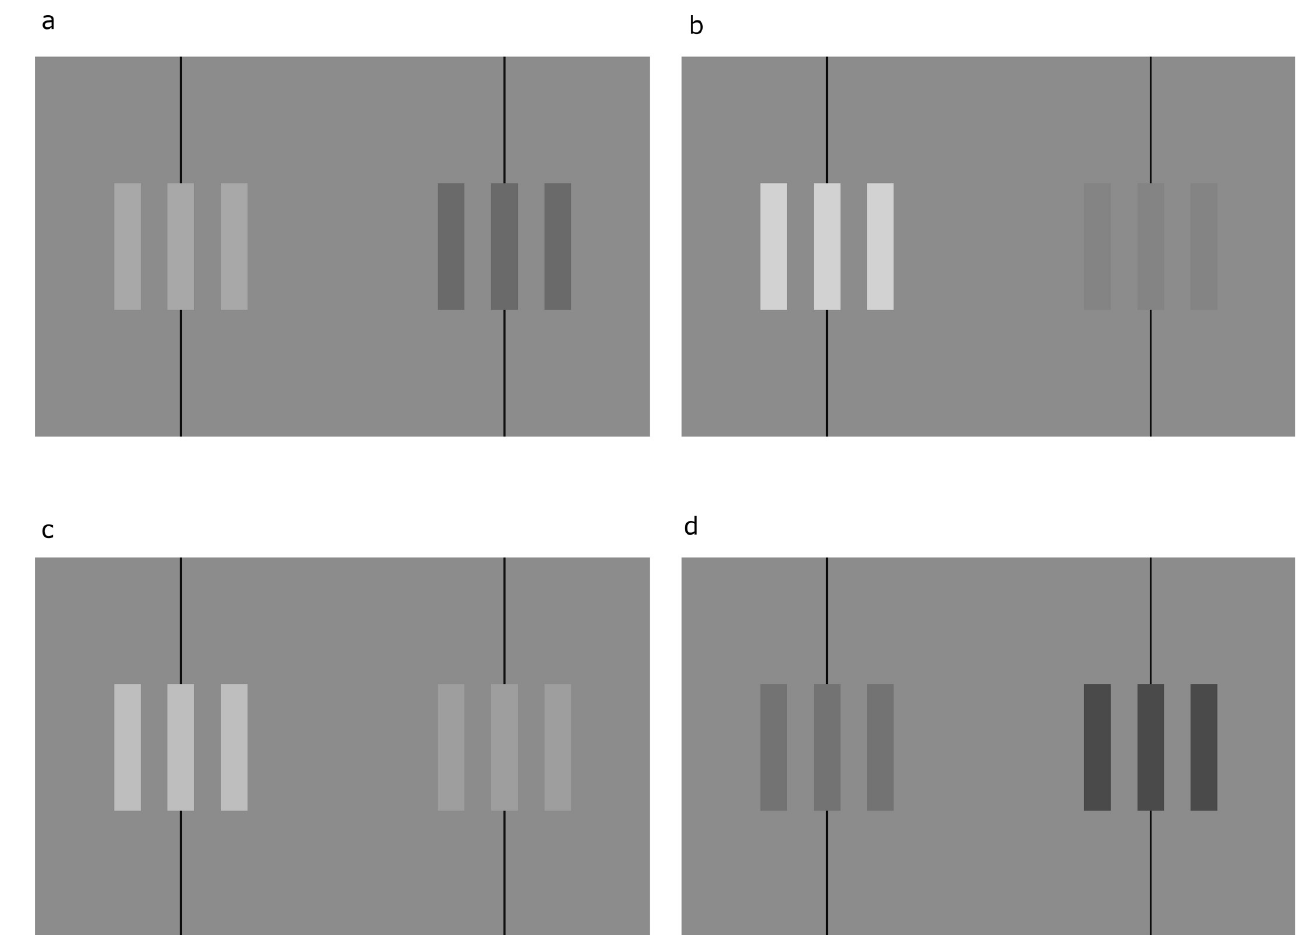
Fig 5. Sample Experiment II stimuli. (a) The "average luminance" condition, with luminance values derived from a grating with dichoptic luminance modulation of 0.4. (b) "Light luminance bars," from dichoptic luminance modulation of 0.4. (c) "Light contrast bars," from dichoptic contrast modulation of 0.5. (d) "Dark bars," from dichoptic luminance modulation of 0.4. The bars straddle the background in (a) and (b), and not in (c) and (d). at the bottom of each plot are the dichoptic luminance or contrast modulation values in the original grating images of Experiment I, allowing direct comparison of these plots to those in Fig 4. That is, the "average luminance" (avg) and "light luminance bars" (llm) plots can be com- pared to the plots for images with dichoptic luminance modulation, the "light contrast bars" (lcn) plots can be compared to the plots for images with dichoptic contrast modulation, and the "dark bars" (dar) plots can be compared to both luminance and contrast modulations. Again, the vertical dotted lines indicate the disparity at which one of the dichoptic gratings pairs’ bright bars fall below the luminance of the background.